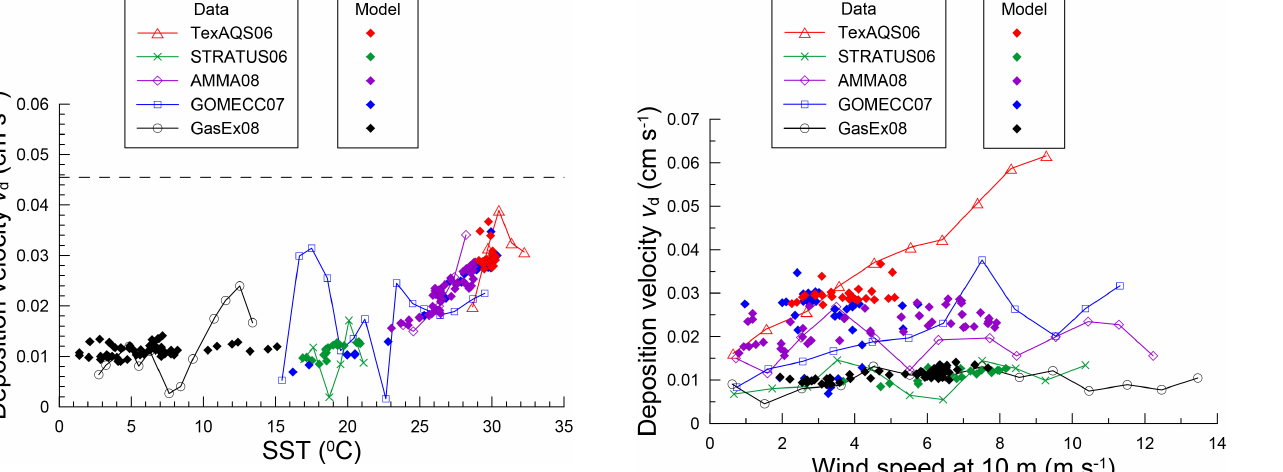
Figure 7. Ozone dry deposition velocity ( v d ) as a function of wind speed at 10m height from five field experiments (Helmig et al., 2012) and the corresponding values obtained from the ACCESS- UKCA model using the two-layer reactivity scheme for ozone de- position to the